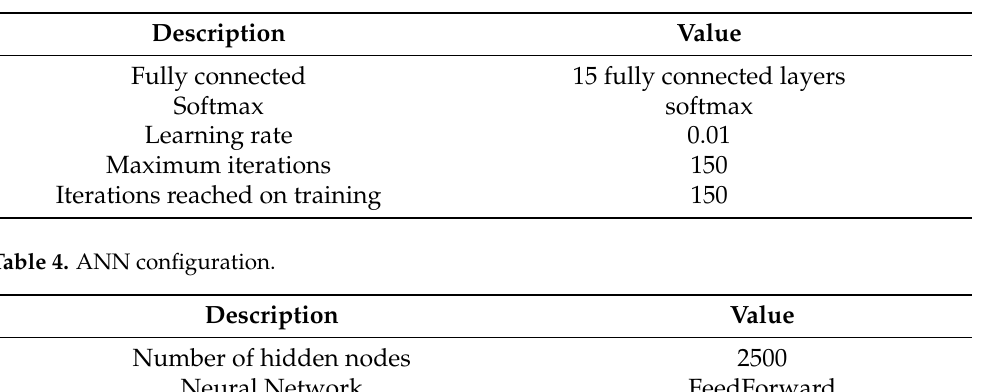
Table 3. CNN parameters and configurations.